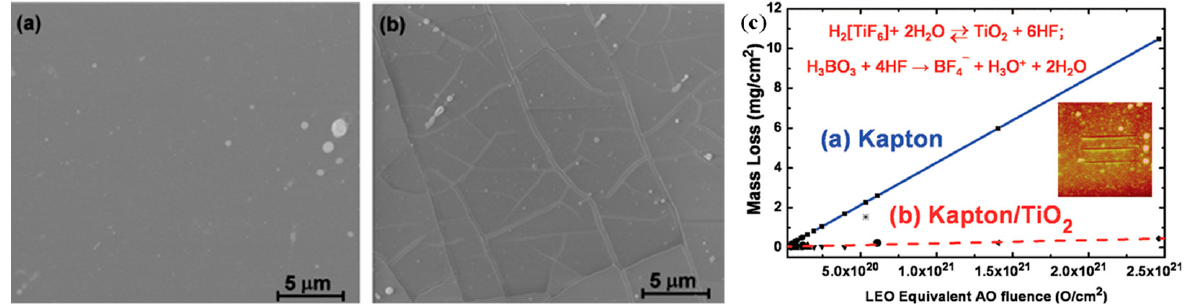
Figure 19. ESEM images of TiO 2 ‐ coated Kapton sample ( a ) before and ( b ) after exposure to 1.5 × 10 19 atoms cm − 2 AO fluence. ( c ) Kapton and titania ‐ coated Kapton mass loss as a function of AO fluence. Inset: AFM images of scratch grooves on TiO 2 ‐ coated Kapton. Reprinted with permission from Ref. [174]. 2010, ACS Publications.